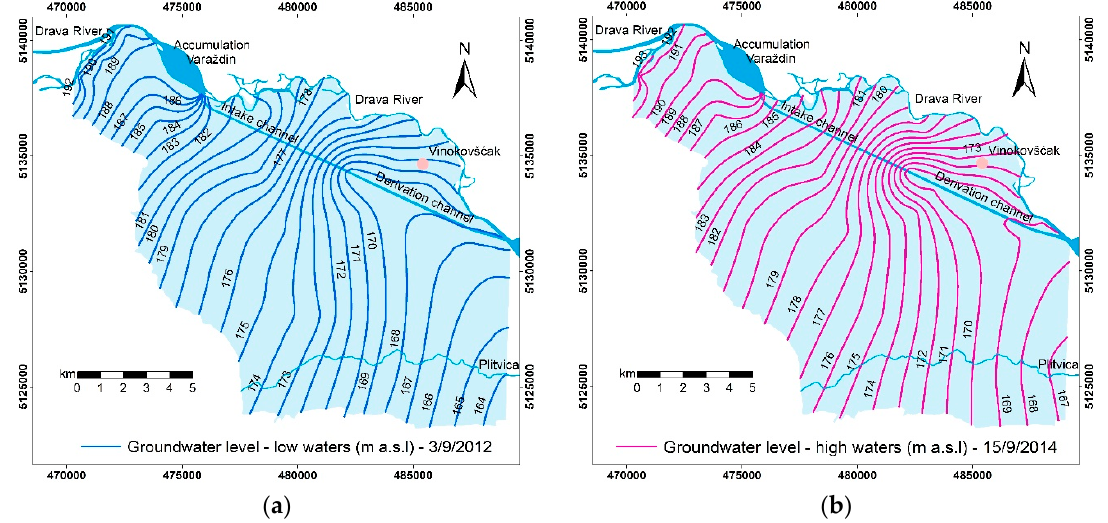
Figure 6. Map of equipotential lines for ( a ) low water levels ( b ) high water levels. Nearly all surface water features are in interaction with groundwater, except intake channel of HPP Varaždin, which is lined with concrete and has no impact on groundwater flow net. There is a clear bending of the equipotential lines towards derivation channel of